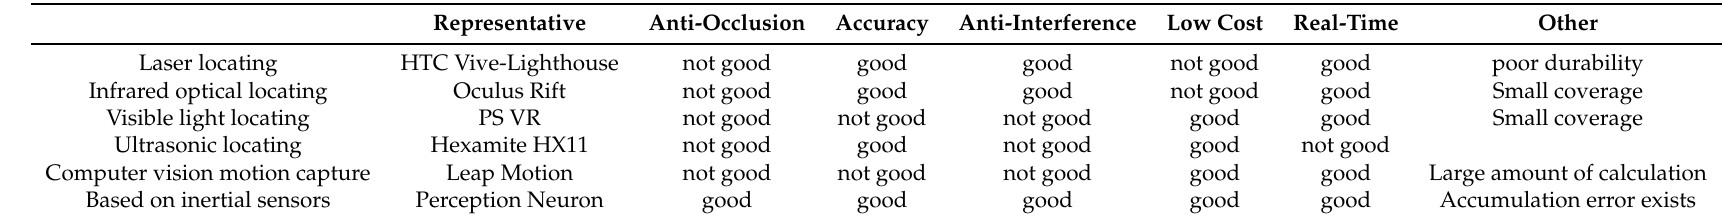
Table 1. Comparison of Motion Capture or Space Locating